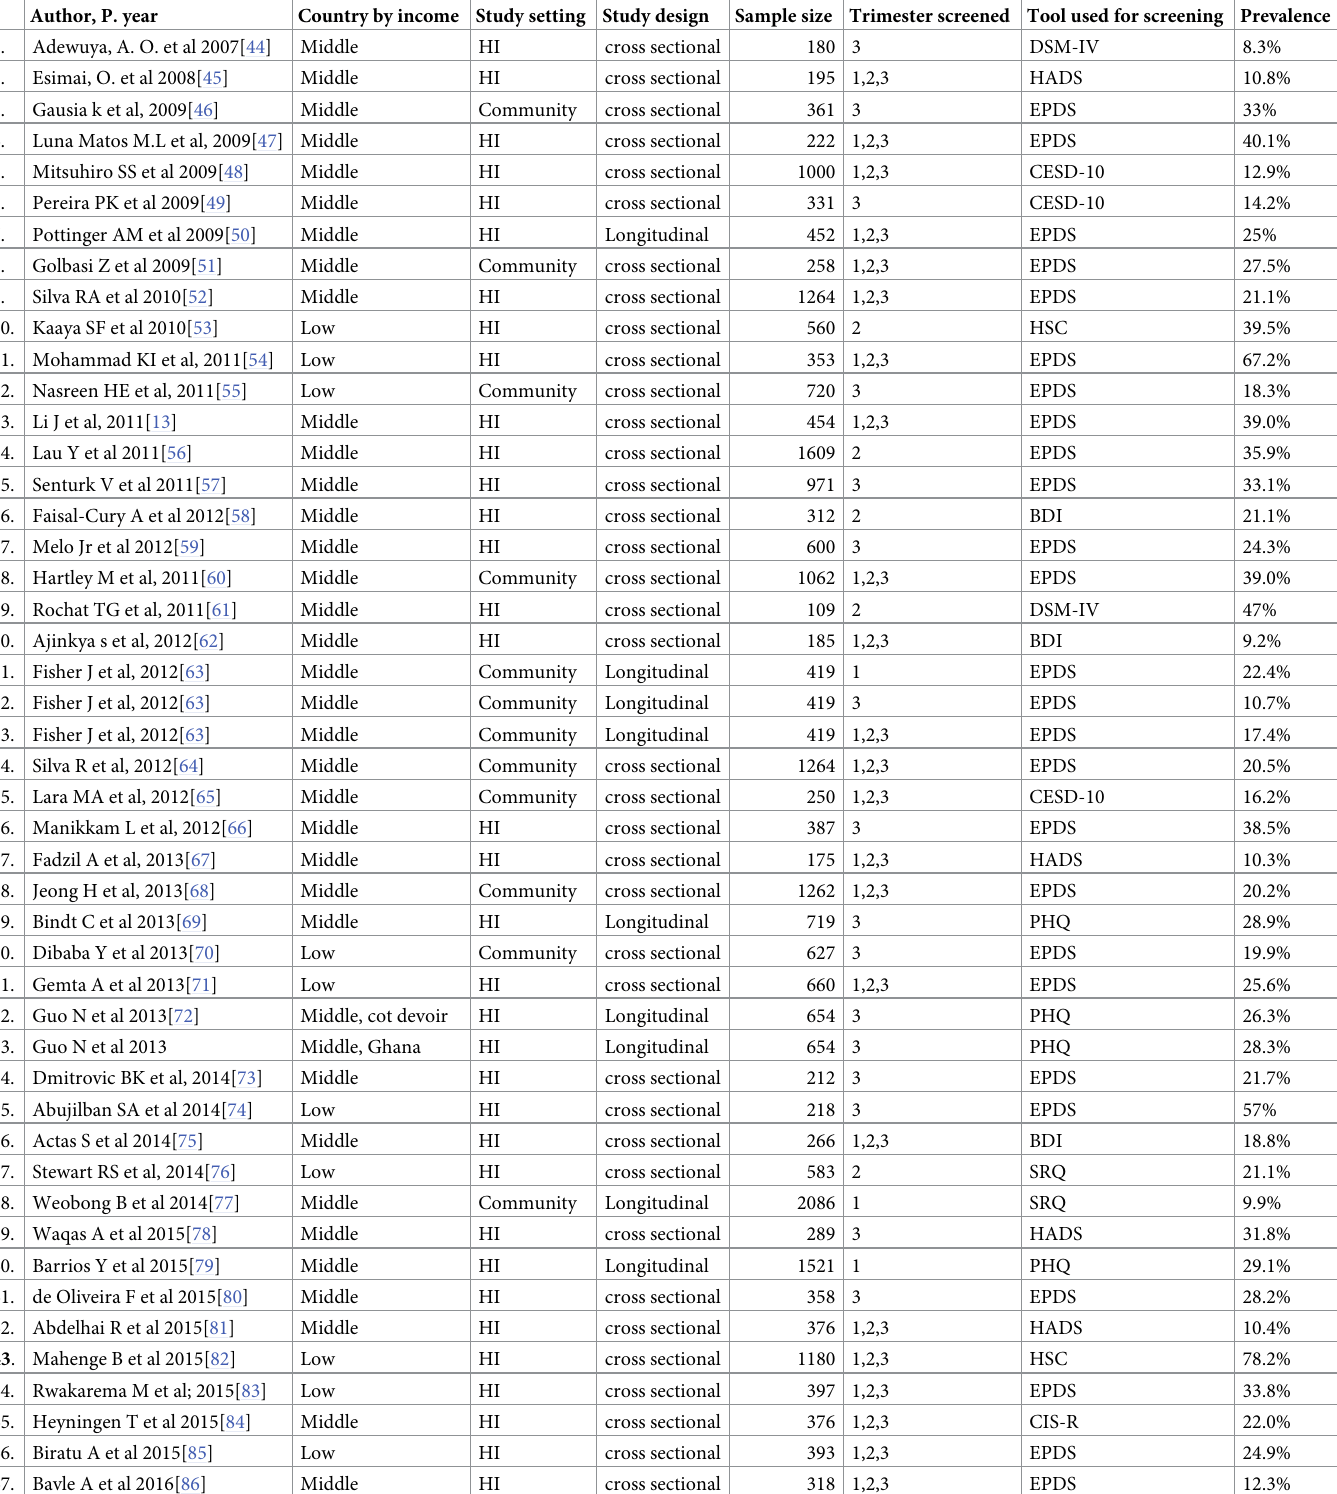
Table 1. Summary of studies conducted on antenatal depression in low and middle-income countries, (N = 64, in the year